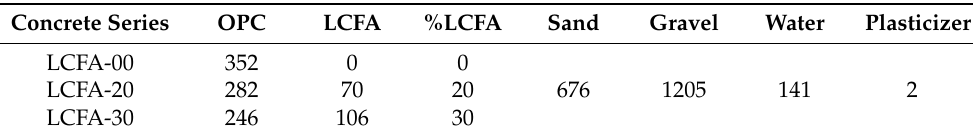
Table 3. Concrete mix design (kg/m 3